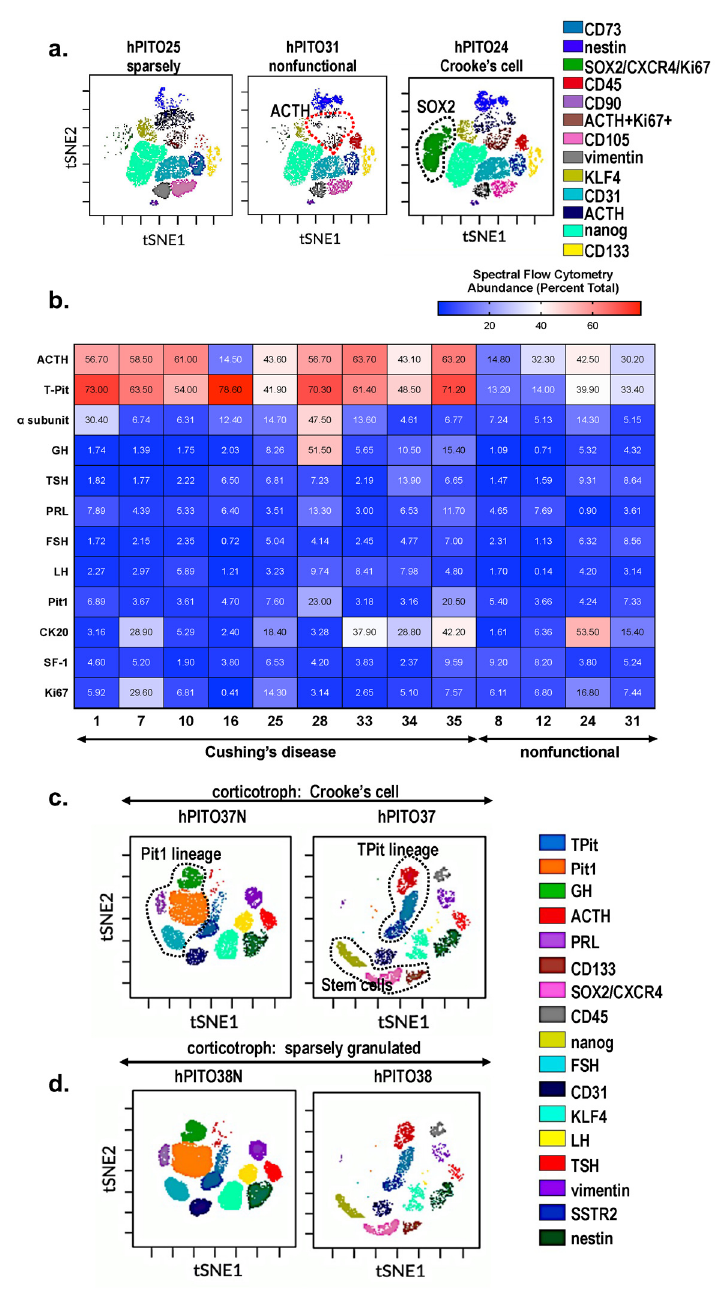
Figure 2. Cell heterogeneity of corticotroph hPITOs. ( a ) viSNE maps define spatially distinct cell populations using pituitary specific cell lineage, stem cell, and transcription factor markers. Cell populations were quantified in organoids generated from CD patients with corticotroph adenomas (sparsely granulated and Crooke’s cell adenoma) or patients with nonfunctional corticotroph adeno- mas. ( b ) Quantification of the abundance of cells expressing pituitary specific markers as a percent total. viSNE maps define spatially distinct cell populations in organoid cultures generated from CD patient with ( c ) corticotroph adenoma (hPITO37, Crooke’s cell adenoma) and adjacent normal tissue (hPITO37N), or ( d ) sparsely granulated corticotroph adenomas (hPITO38) and adjacent normal tissue (hPITO38N).